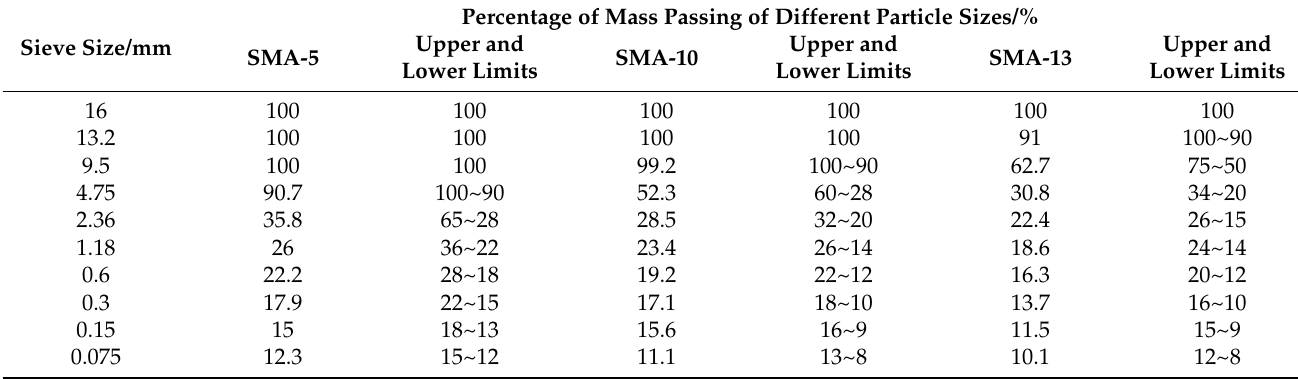
Figure 1. Combined gradation curves. Table 7. The sieve passing rate of three kinds of aggregates.